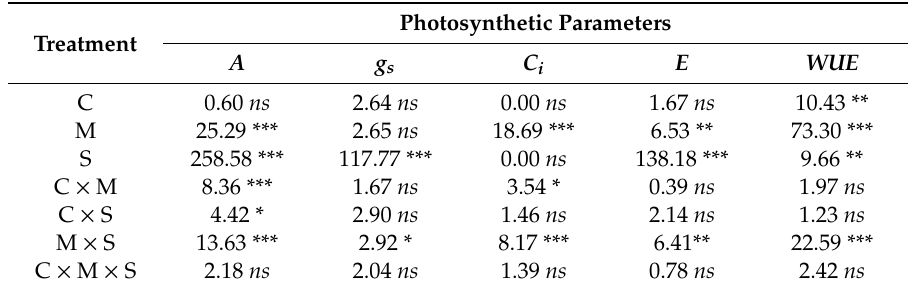
Table 3. Photosynthetic parameters of two wheat cultivars (C) in response to microbial treatment (M), salt stress (S), and their